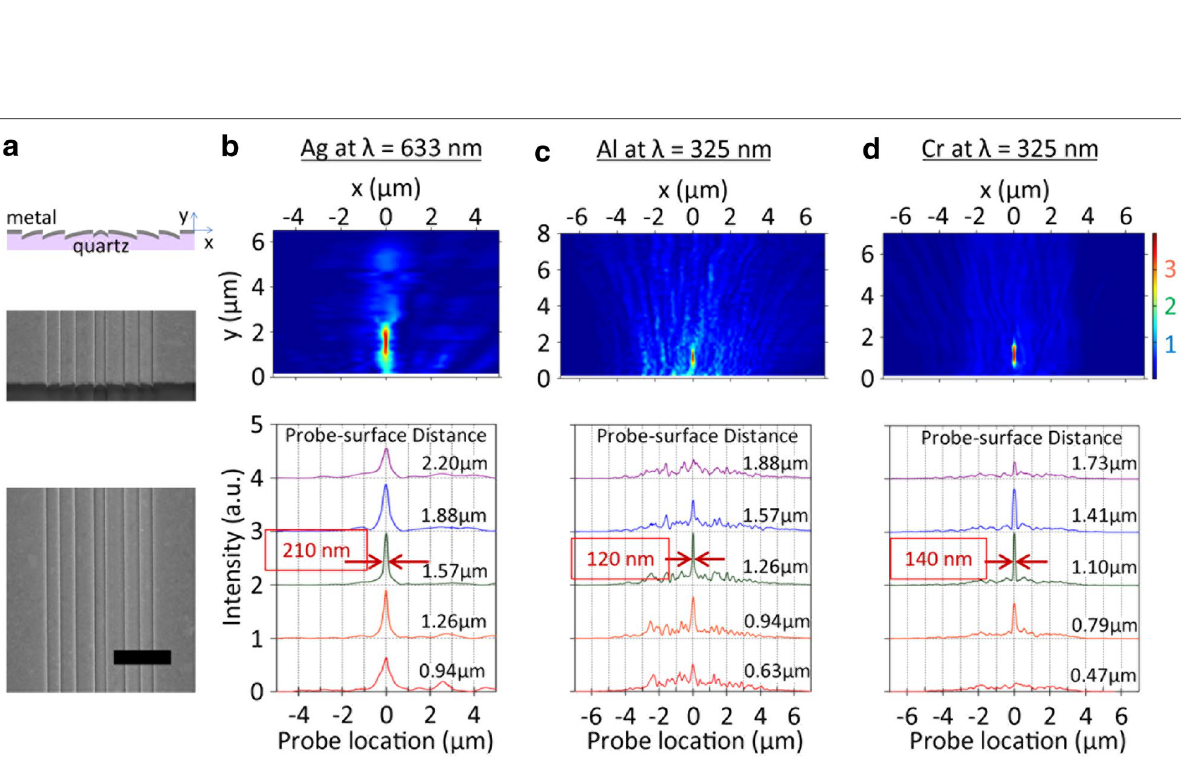
1.26 µm. d Cr lens at 325 nm wavelength. A minimal =